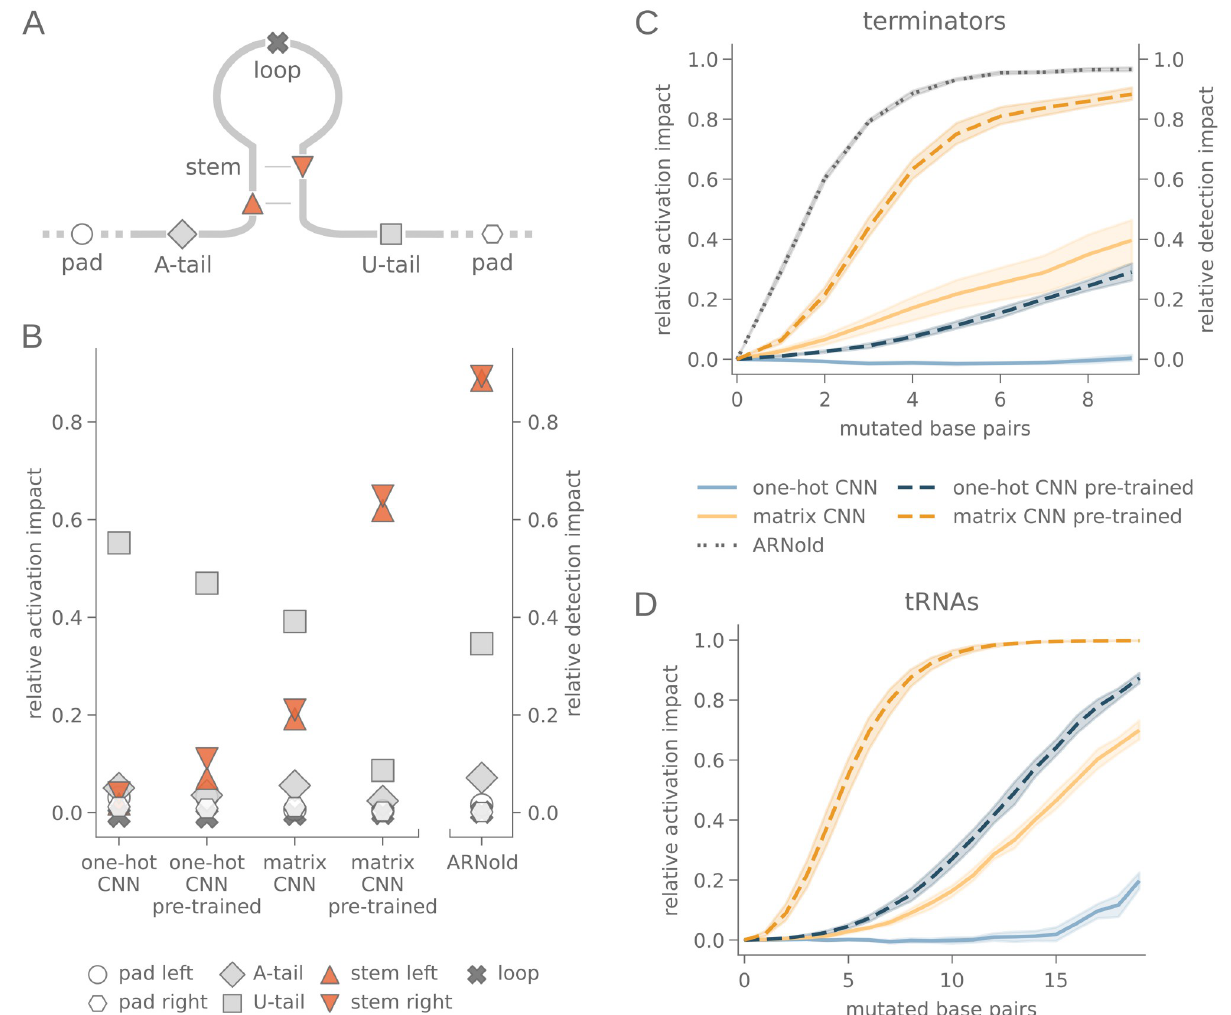
Fig 2. Impact of sequence and structure on terminator and tRNA recognition. (A) Intrinsic terminators comprise five sections: The hairpin structure in the center consists of a stem and a loop, framed by an A-rich zone (A-tail) on the 5’-end and a longer U-rich zone (U-tail) on the 3’-end. The terminator data used in this study additionally contain adjacent genomic sequences of the terminator ( left pad and right pad ). (B) Impact of terminator sections as relative activation impact on CNN models (left) and relative detection impact on ARNold (right). Random mutations were introduced in each of the 7 sections of the transcription terminators. The relative activation impact on the models is calculated from the difference between the model output corresponding to the original sequences and sequences with random nucleotide mutations in half of all nucleotides per section. The relative detection impact for ARNold is calculated for the same mutated sequences, and is estimated by averaging over binary outputs across the mutation data set. (C) Impact of the base pairings in the stem of terminators for a growing number of mutated base pairs as relative activation impact on CNN models and relative detection impact on ARNold. The relative activation impact is calculated from the difference between the model output corresponding to mutations which retain or disrupt the pairing state in the stem structure. The relative detection impact for ARNold is calculated for the same mutated sequences, and is estimated by averaging over binary outputs across the mutation data set. (D) Relative activation impact of the base pairings in the stems of tRNAs on CNN models, for a growing number of mutated base pairs. The relative activation impact is calculated from the difference between the model output corresponding to mutations which retain or disrupt the pairing state in the stem structure. (B), (C): For k = 1, ... , 10 and n 2 {93, 84, 102, 91, 94, 92, 93, 113, 99, 92} (D): For k = 1, ... , 10 and n 2 {198, 203, 194, 202, 201, 201, 199, 201, 194, 201}.